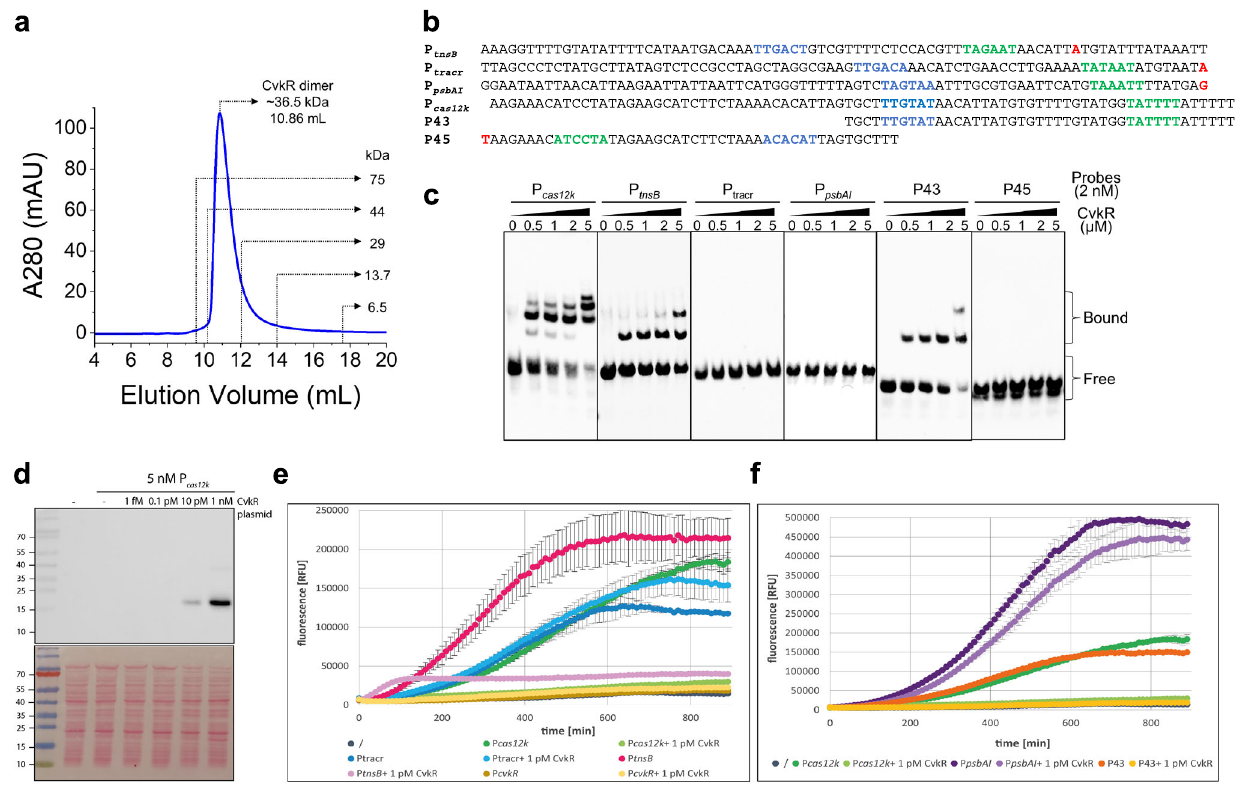
Fig.5|Assaystotest cas12k promoterelements.a Molecularweightestimatesof CvkRonsizeexclusionchromatography(SEC)withSuperdex7510/300GLcolumn (GE Healthcare). Calibration standards are indicated. The elution volume of CvkR was~10.86mL,correspondingtoamassof~36.5kDa(twiceitscalculatedmolecular weight). mAU, milliabsorbance units. b Sequences of the tested promoter frag- ments. The probe P45 indicates the reverse complementary sequence of cvkR promoter.Putative − 35and − 10of cas12k,tnsB ,tracrRNA, psbAI and cvkR promoter elements are shown in blue and green, respectively. The TSSs were included and marked in red. c EMSA assays showing the binding ability of CvkR to P cas12k , P tnsB , P tracr , P psbAI and truncated fragments (P43 and P45) of P cas12k . The data are pre- sentative from two or three independent experiments. The free probe and com- plexesofprotein-DNAcomplexesweremarkedas “ Free ” and “ Bound ”